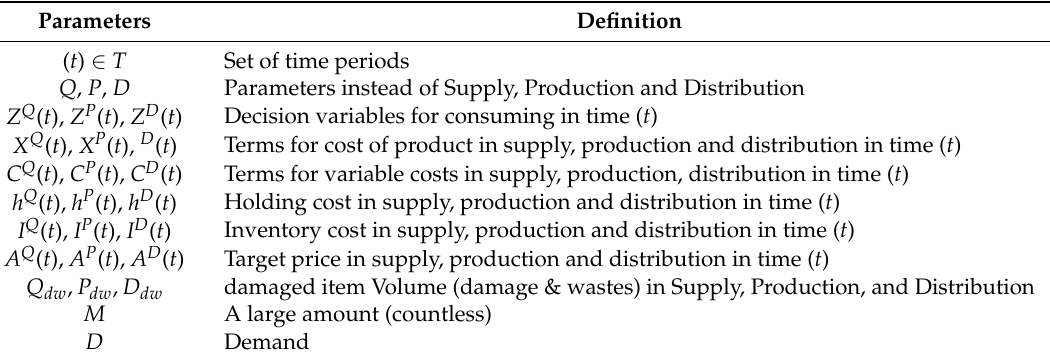
Table 1. Determination the parameters with definition in Supply, Production and Distribution